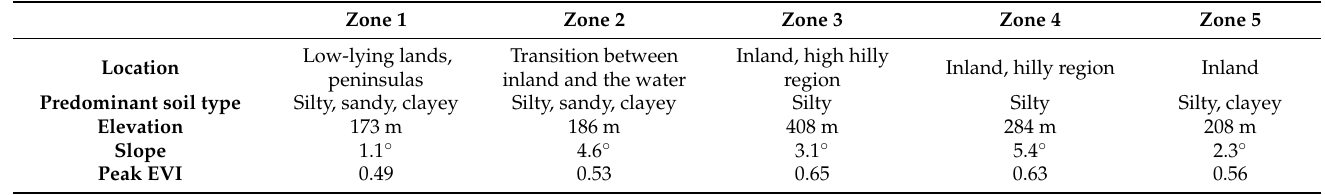
Table 2. Characteristics of each zone from the all-metrics-based zonation. Slope and EVI values correspond to the mean of the group, and elevation values to the median. The ANOVA test confirmed that these five zones are significantly different for these metrics ( p -values < 1 × 10 − 10 ). Zone 1 Zone 2 Zone 3